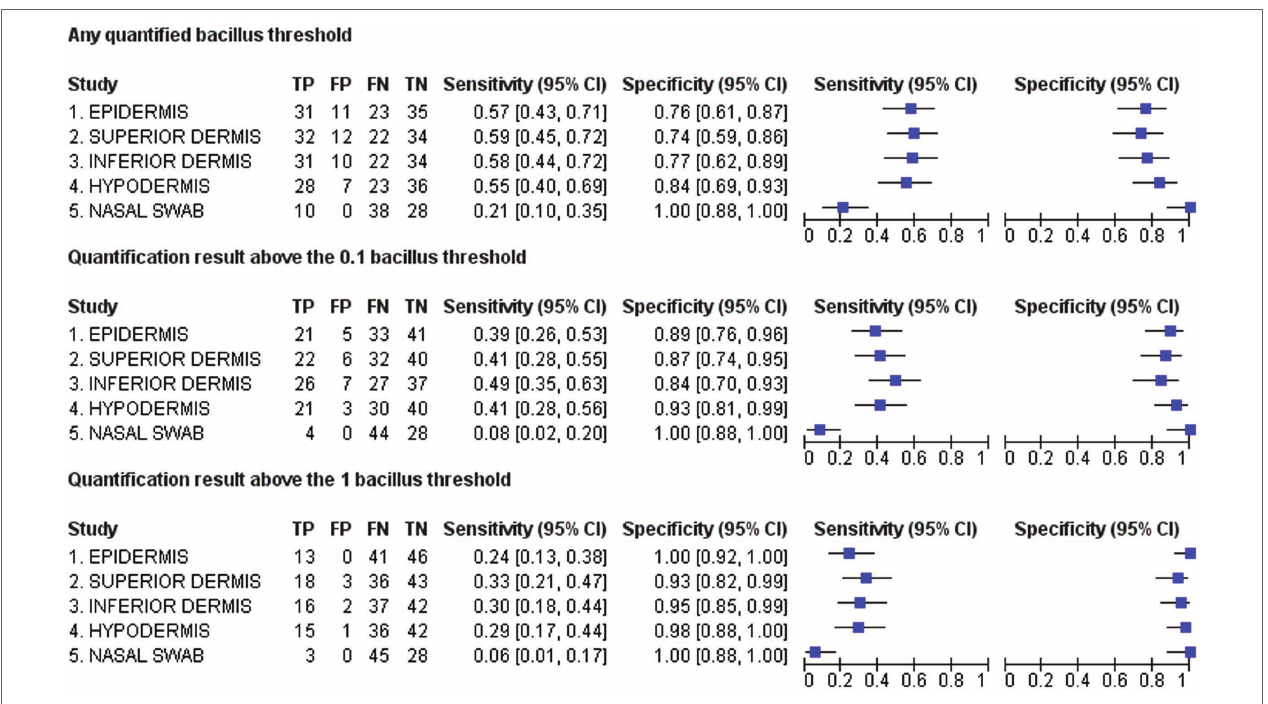
FIGURE 3 | Forest plots representing sensitivity and specificity values. TP, true positive; FP, false positive; FN, false negative; TN, true